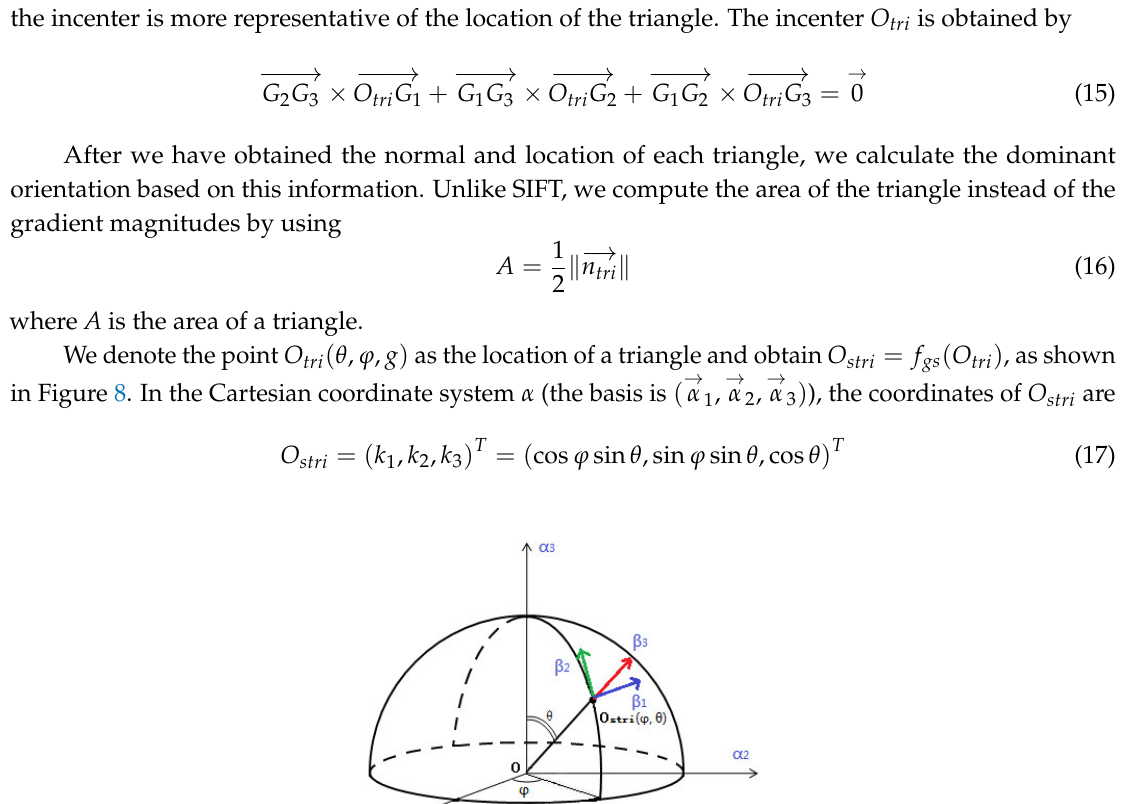
Figure 8. α and β coordinate systems.